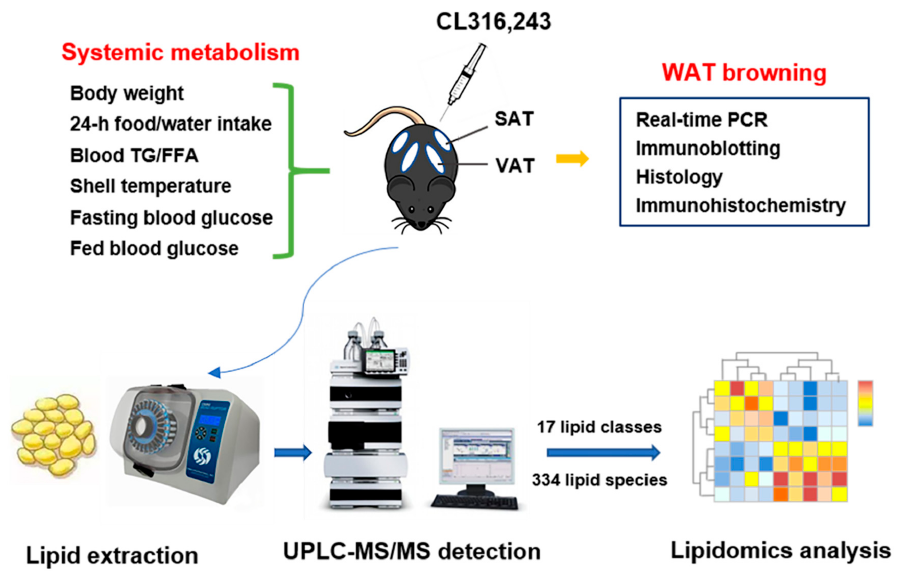
Figure 1. A schematic diagram of experimental design.